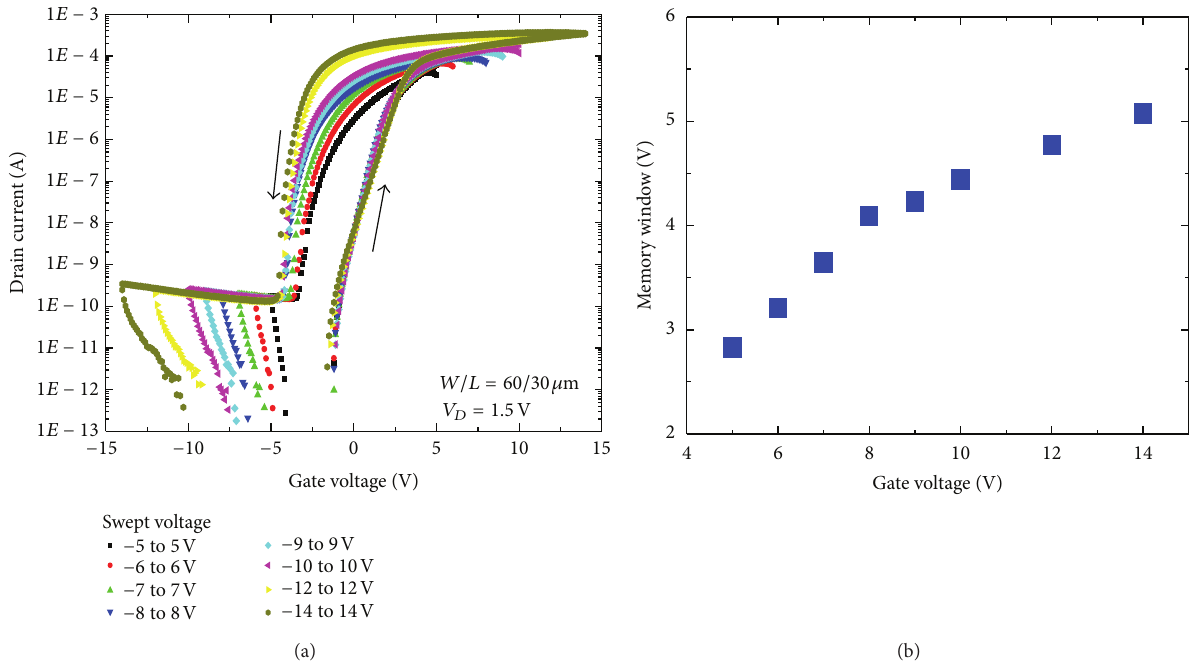
Figure 6: (a) Transfer curves and (b) memory window as a function of gate sweep